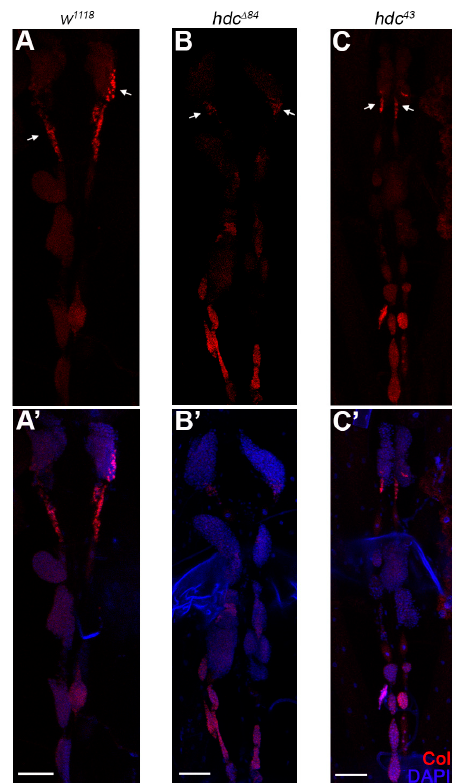
Figure 6. Integrity of the lymph gland and the PSC in hdc mutants. ( A , A’ ) Anti-Collier staining (red) of the lymph gland of the w 1118 control larva; ( B – C’ ) Anti-Collier staining (red) of the lymph gland of the hdc ∆ 84 ( B , B’ ) and hdc 43 ( C , C’ ) mutant larvae. The size and morphology of the lymph gland and the PSC in the hdc mutants did not differ from the control. Nuclei were stained with DAPI (blue) ( A’ , B’ , C’ ). Arrows point to the PSC of the lymph gland. Images were taken with Leica TCS SP5 Confocal Microscope, original magnification × 20, and processed with LAS AF Lite (Leica Microsystems CMS GmbH), ImageJ and Adobe Photoshop CS2 softwares. Scale bars: 50 µm .